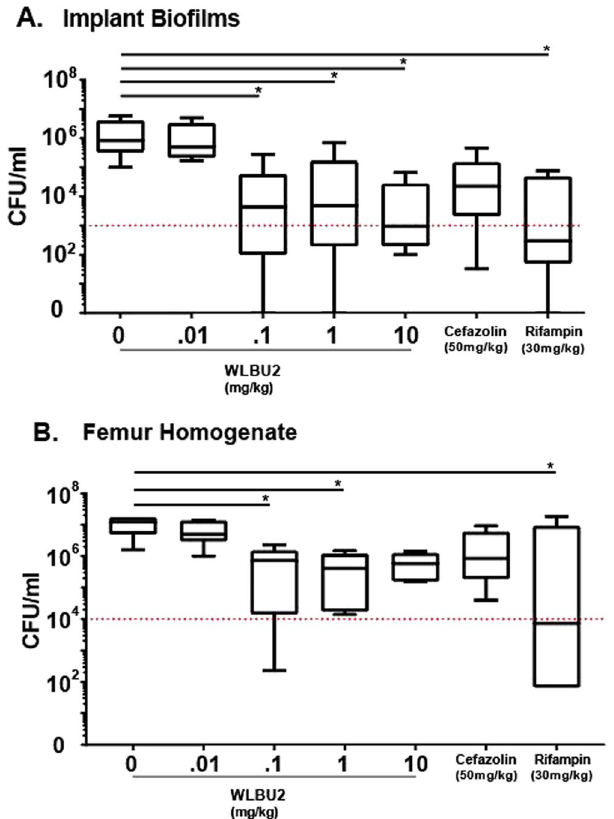
Figure 4. ( A – B) Periprosthetic joint infection (PJI) murine model testing bactericidal efficacy of WLBU2 in vivo . Mice received Kirschner wire implant up femoral canal and 1 × 10 6 CFUs of SH1000 injected into knee joint. Groups received log increases in WLBU2 intraperitoneally twice a day for 3 days and compared to untreated as well as traditional antibiotic treated groups (cefazolin and rifampin). ( A ) Kirscher wire implant placed into 1% Tween 20 and sonicated 10 minutes, drop assays on blood agar plates shows significant reduction of implant biofilm in WLBU2 groups (0.1–10 mg/kg), red dashed line represents 99.9% drop in live bacteria compared to untreated. ( B ) Proximal femur piece cut placed into 1% Tween 20 and homogenized for 60 seconds, shows significant reduction in local bacterial tissue burden in WLBU2 groups, red dashed line represents 99.9% drop in live bacteria compared to